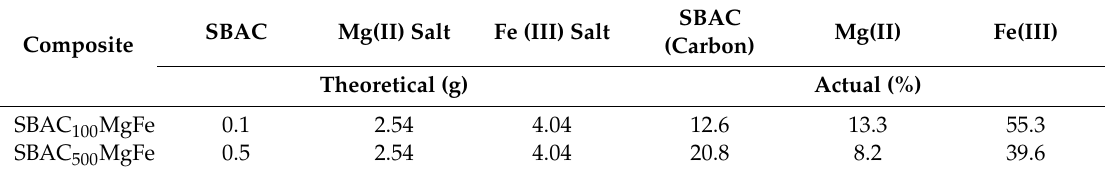
Table 1. Mix design mass and percent composition of SBAC and MgFe in SBAC-MgFe composites.